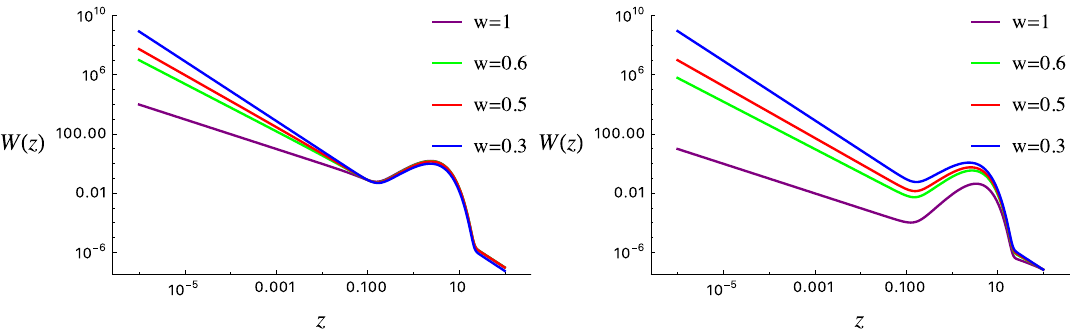
Figure 17 . This shows the lepton number violating rate term W ( z ) in the Boltzmann equation with the e(cid:11)ective equation of state parameter w = 0 : 3, 0 : 5, 0 : 6 and 1, and z (cid:3) = 0 : 1 (left-hand (cid:12)gure) and z (cid:3) = 100 (right-hand (cid:12)gure). The other parameters here are M 1 = 10 10 GeV and K = 5.